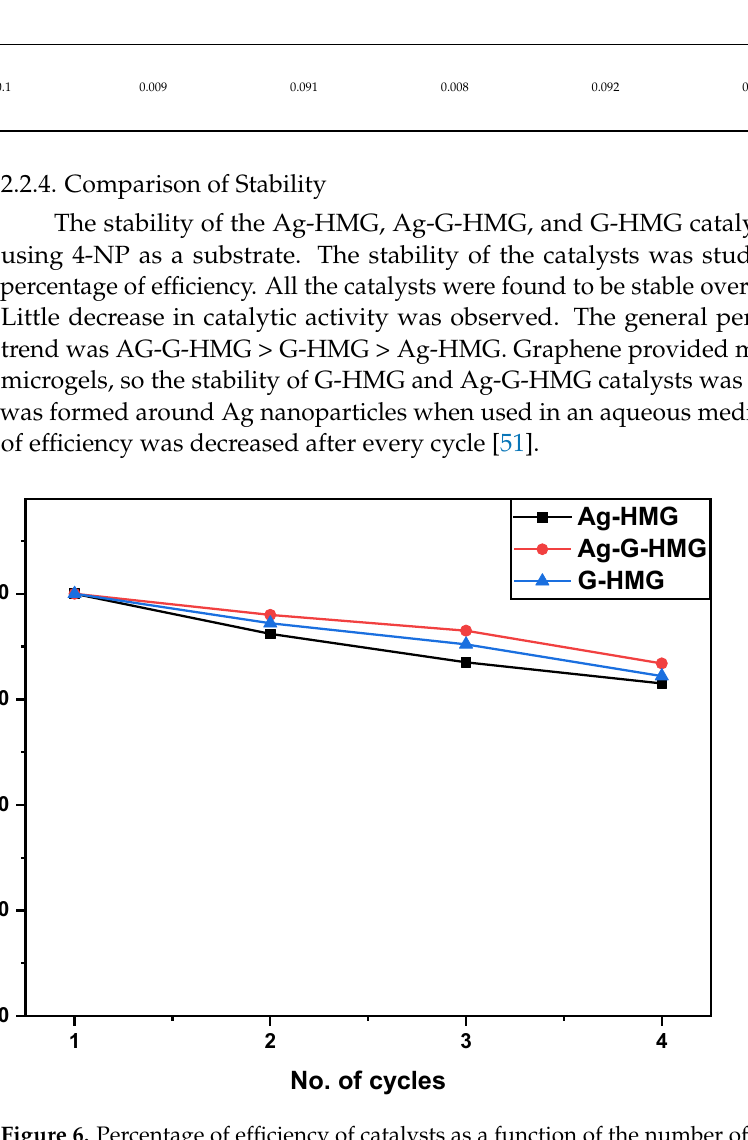
2.2.4. Comparison of Stability The stability of the Ag-HMG, Ag-G-HMG, and G-HMG catalysts has been studied using 4-NP as a substrate. The stability of the catalysts was studied in terms of their percentage of efficiency. All the catalysts were found to be stable over four cycles (Figure